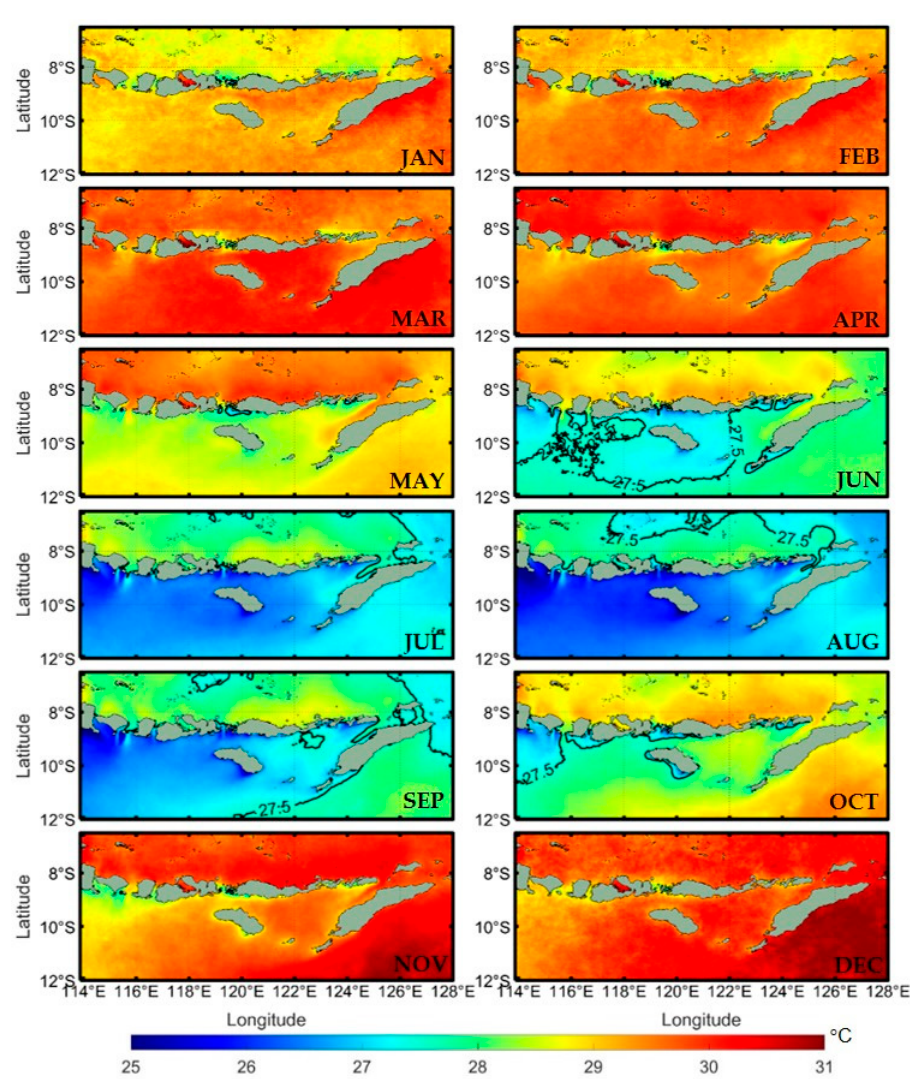
Figure 4. The climatological monthly mean values of sea surface temperature (SST) during 2007–